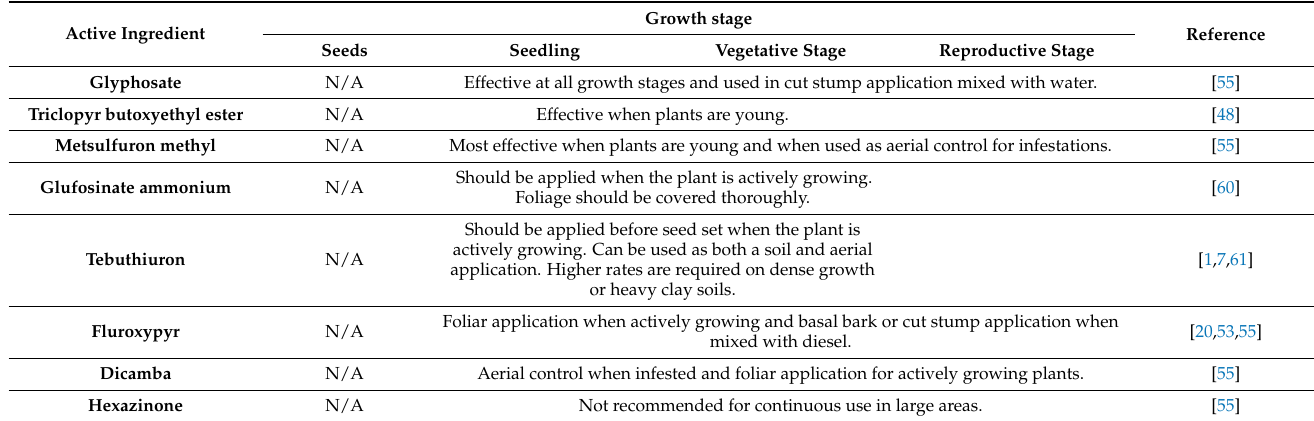
Table 3. Commonly used chemical control measures implemented, mainly in Australia, at different growth stages of Mimosa